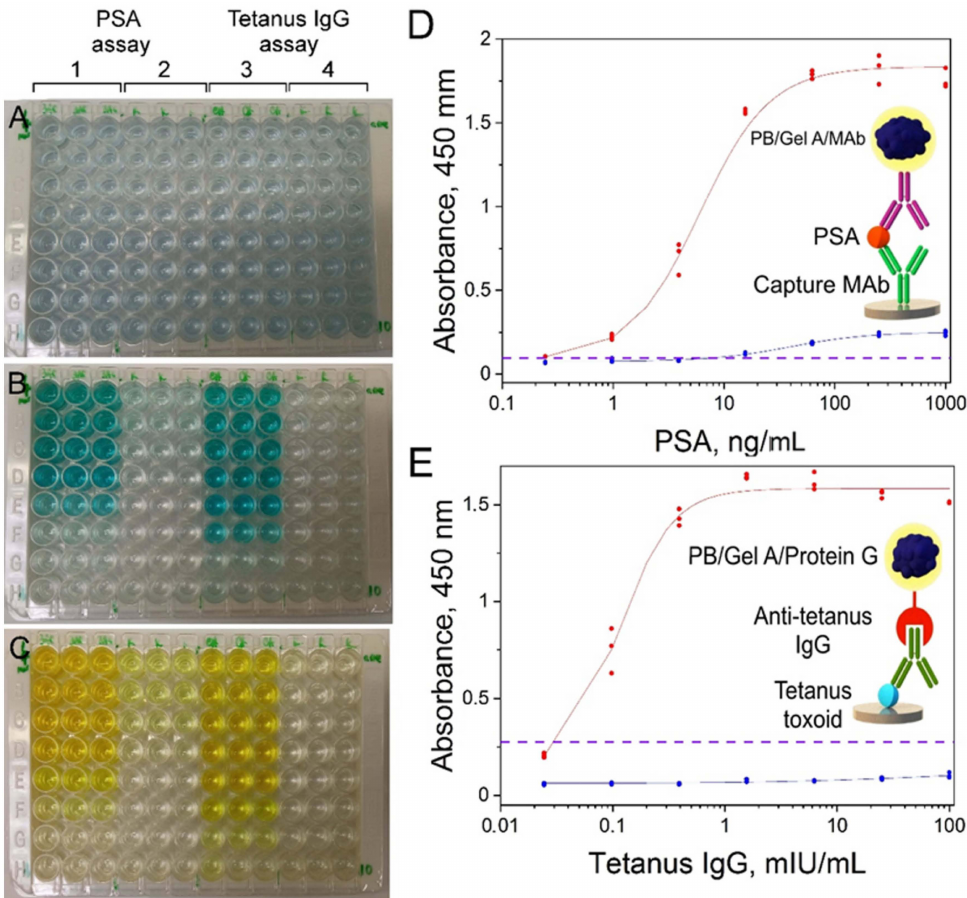
Figure 6. Colorimetric assay of PSA and anti-tetanus IgG. ( A – C ) polystyrene plate at different stages of the assay; ( D , E ) corresponding dose-response curves. ( A ) plate filled with conjugates of Prussian blue nanoparticles, ( B ) plate after 30 min of reaction with substrate, ( C ) plate after the addition of 2 M H 2 SO 4 . Concentration of PSA and anti-tetanus IgG decreased from top to bottom row, 1—wells filled with PB/Gel A/MAb, 3—wells filled with PB/Gel A/Protein G, 2 and 4—wells filled with PB/Gel A/BSA (negative control). Red lines—sigmoidal fit of PSA and anti-tetanus IgG calibration curves. Blue lines—dose-response curves obtained using PB/Gel A/BSA. Purple dashed line at absorbance value equal to mean absorbance of the zero calibrator + 3 × standard deviation. n =